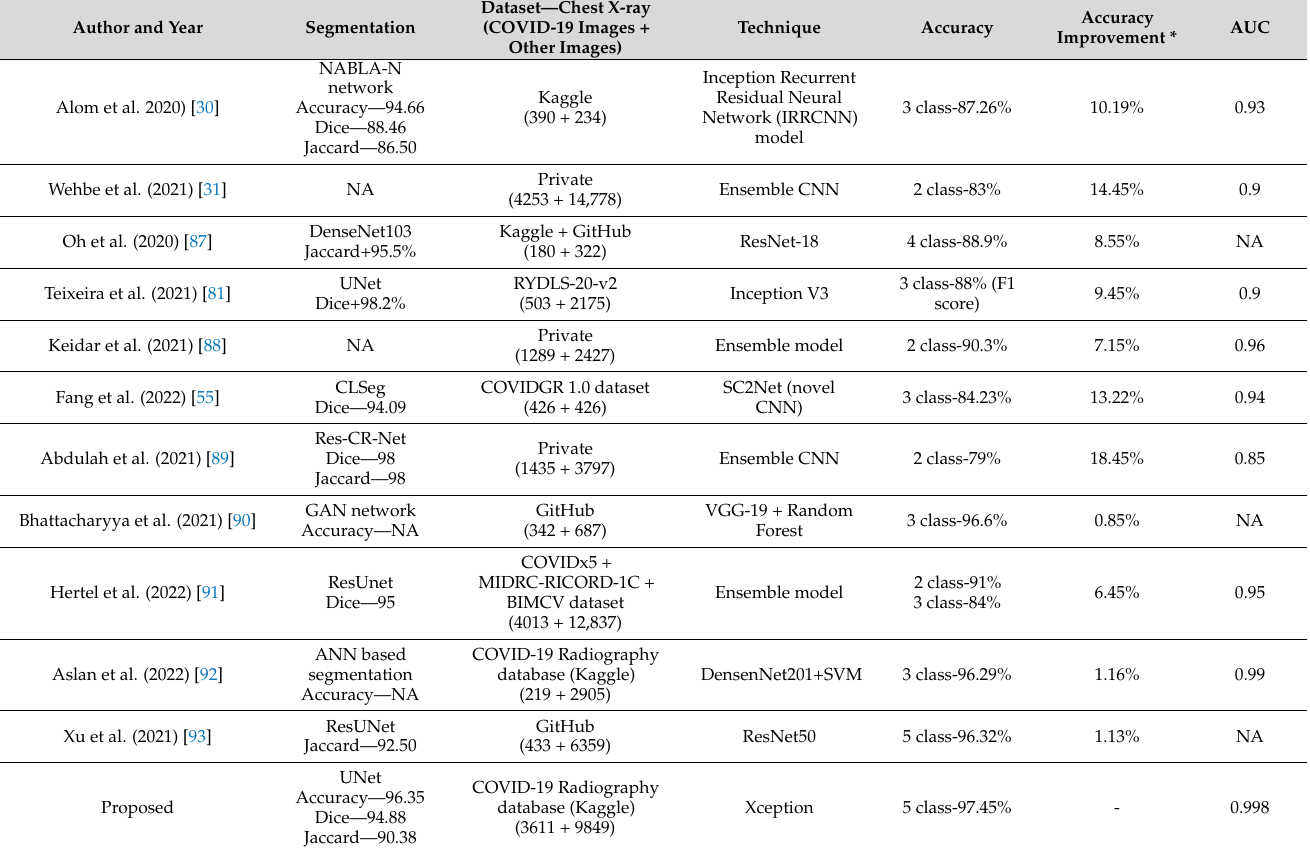
Table 6. Benchmarking table showing a comparison of proposed and existing segmentation-based classification